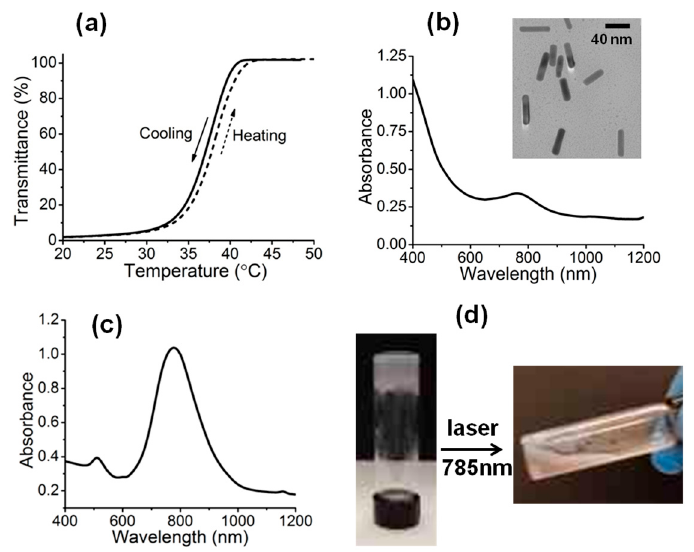
Figure 4. ( a ) Plots of solution transmittance (at 500 nm) vs. temperature of the triblock copolymer in water. ( b ) UV–Vis absorption spectrum of the UCST hydrogel encapsulated with AuNRs; inset: TEM image of the synthesized AuNRs. ( c ) Absorption spectrum of the synthesized gold nanorods (AuNRs) in water. ( d ) Gel–sol transition generated by applying laser.